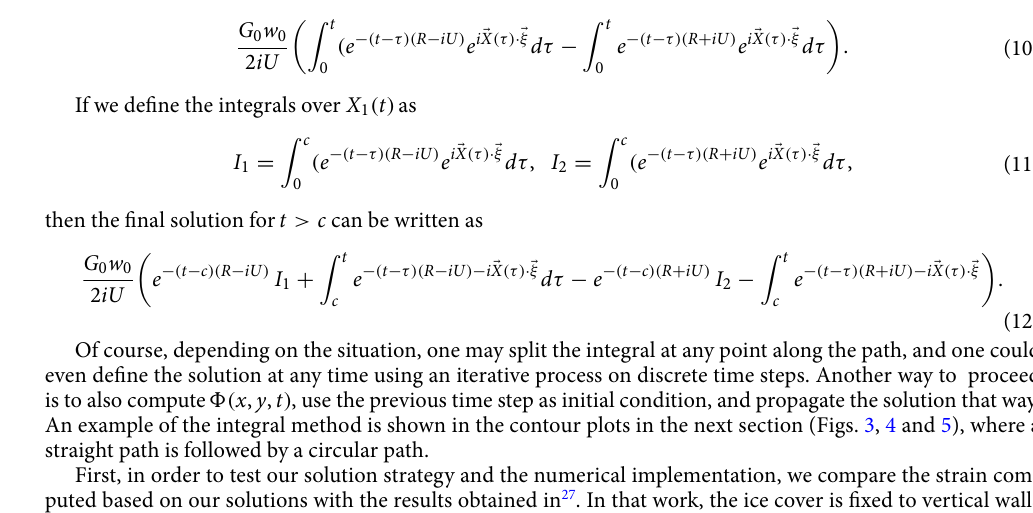
Figure 3. Wave pattern excited by a vehicle of mass 235 kg on an ice plate of thickness h 6.8 m. Left panel shows the vehicle at the beginning before the turn has been started foundation of depth H = 0.32 s ). Center panel shows the wave pattern while the vehicle is turning at t ( t = wave pattern after one full turn has been completed at t